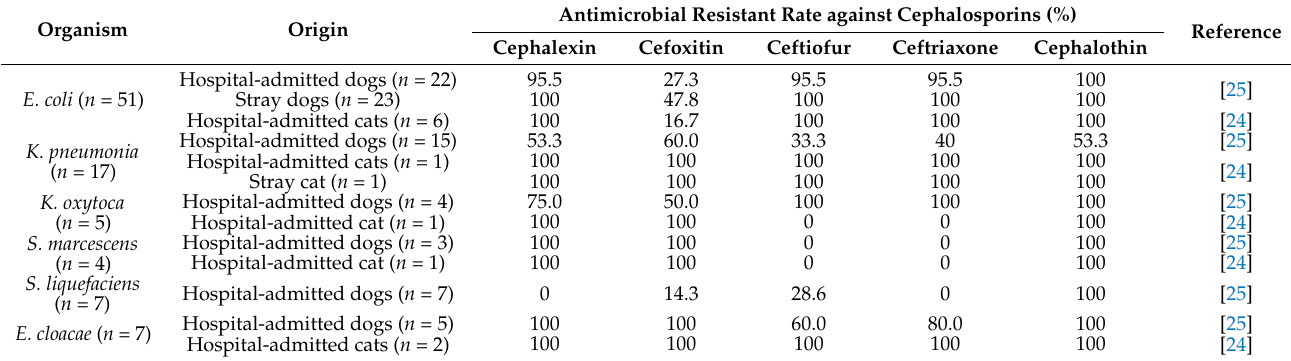
Table 5. The source and antimicrobial resistance characteristics of 91 bacterial isolates used in this study. Organism